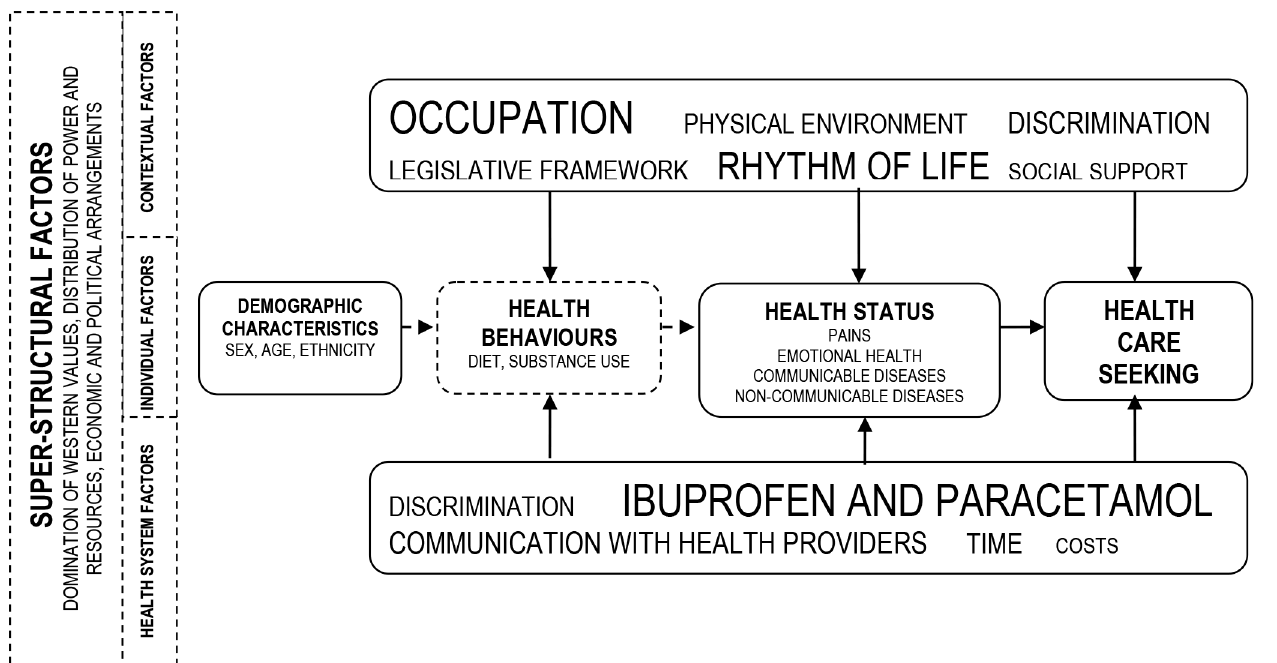
Fig 1. Priority health concerns and determinants identified by study